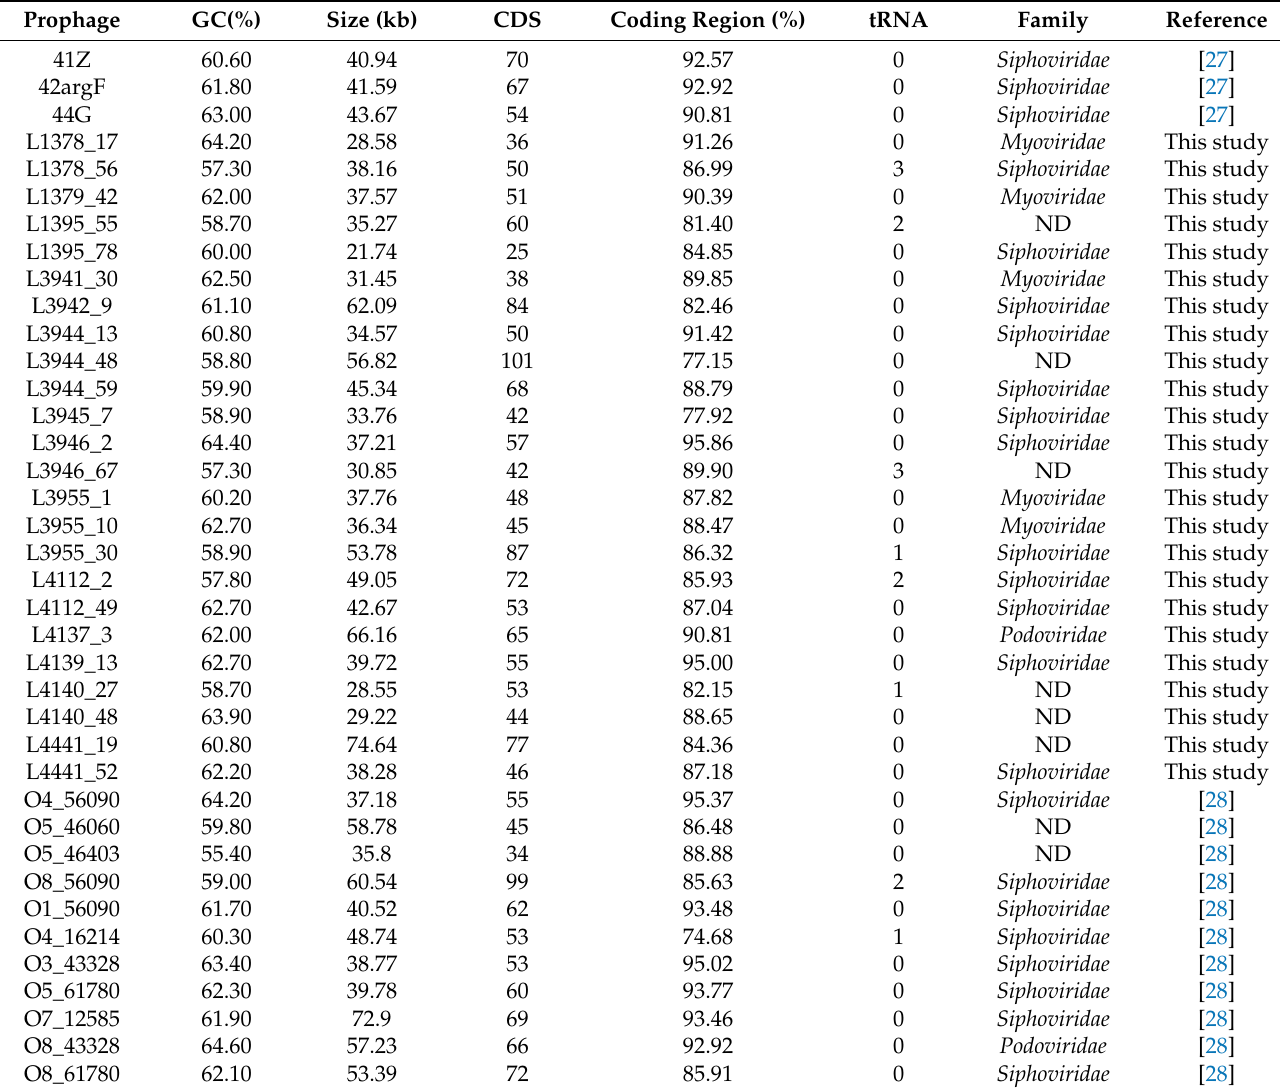
Table 1. Genomic characterization of the complete